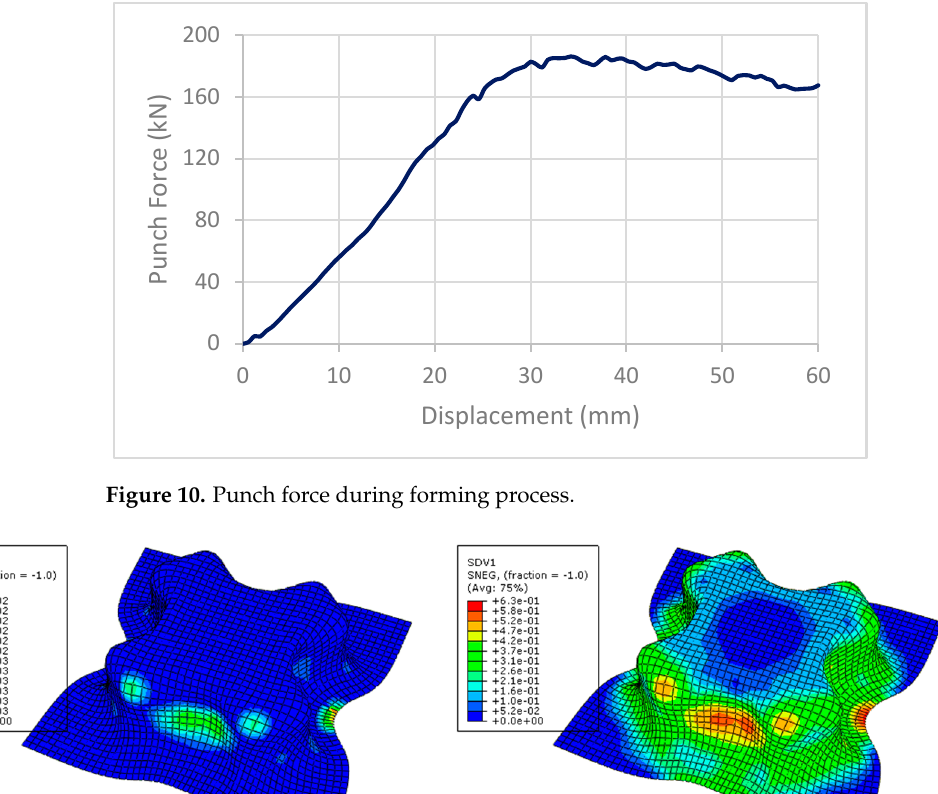
Figure 9. ( a ) Evolution of sheet thickness: along RD, TD, and DD; ( b ) distribution of the thickness in the simulated part.